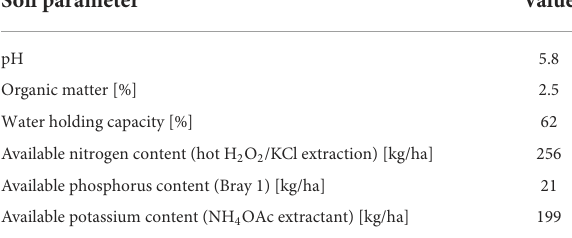
TABLE 4 Baseline soil physical-chemical characteristics of the study area in January